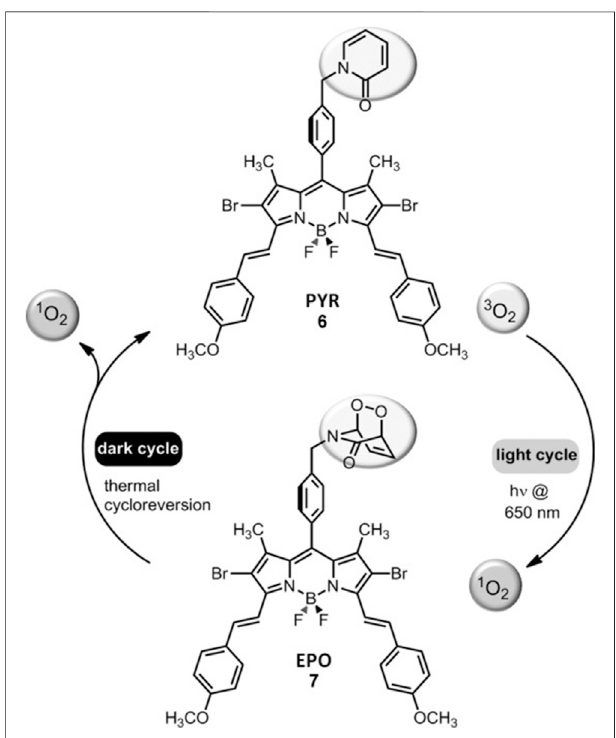
FIGURE8| Fractional PDT. Fractional PDTallowsforthecontinuationof photodynamic process both in the dark and in the light cycles (Turan et